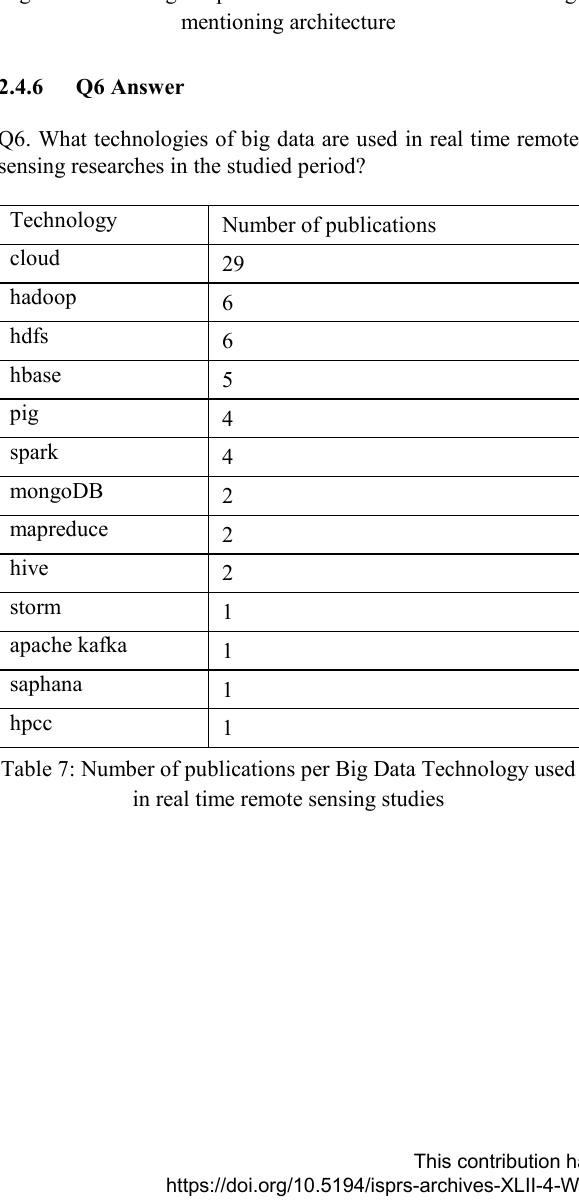
Figure 8. Percentage of publications in real time remote sensing